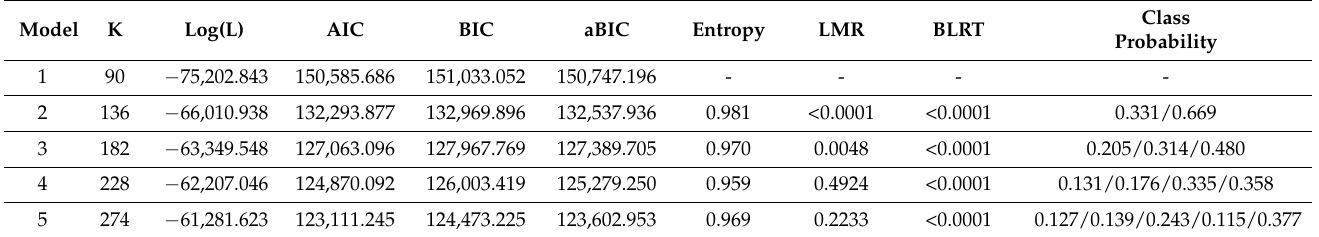
Table 4. Fit statistics for latent profiles: Models 1–5.